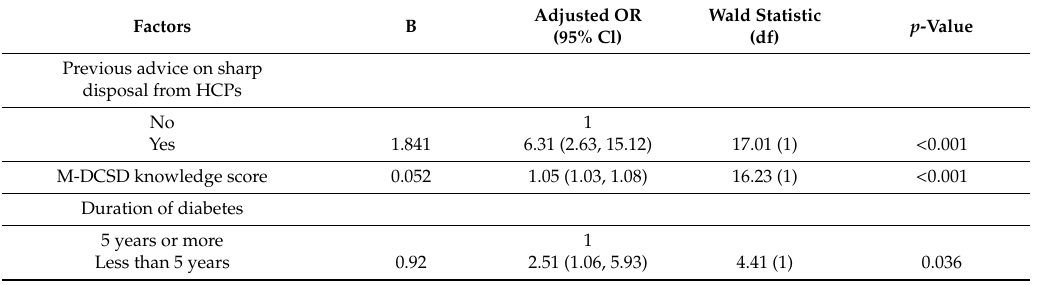
Table 5. Factors contributing to sharp waste disposal at health care facility among Type 2 diabetic patients, using multiple logistic regression ( n =